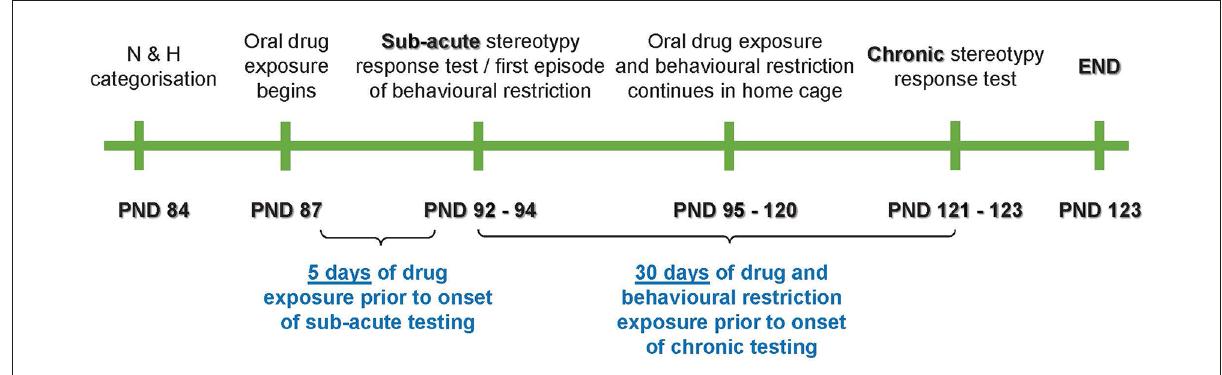
FIGURE1 Schematic representation of the study timeline. PND, postnatal day; N, non-stereotypical; H, high